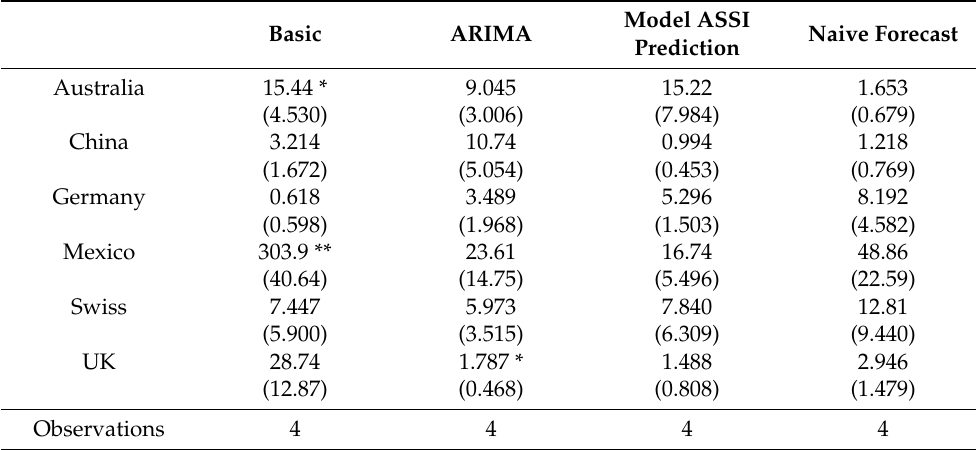
Table 7. Forecast Performance Test.